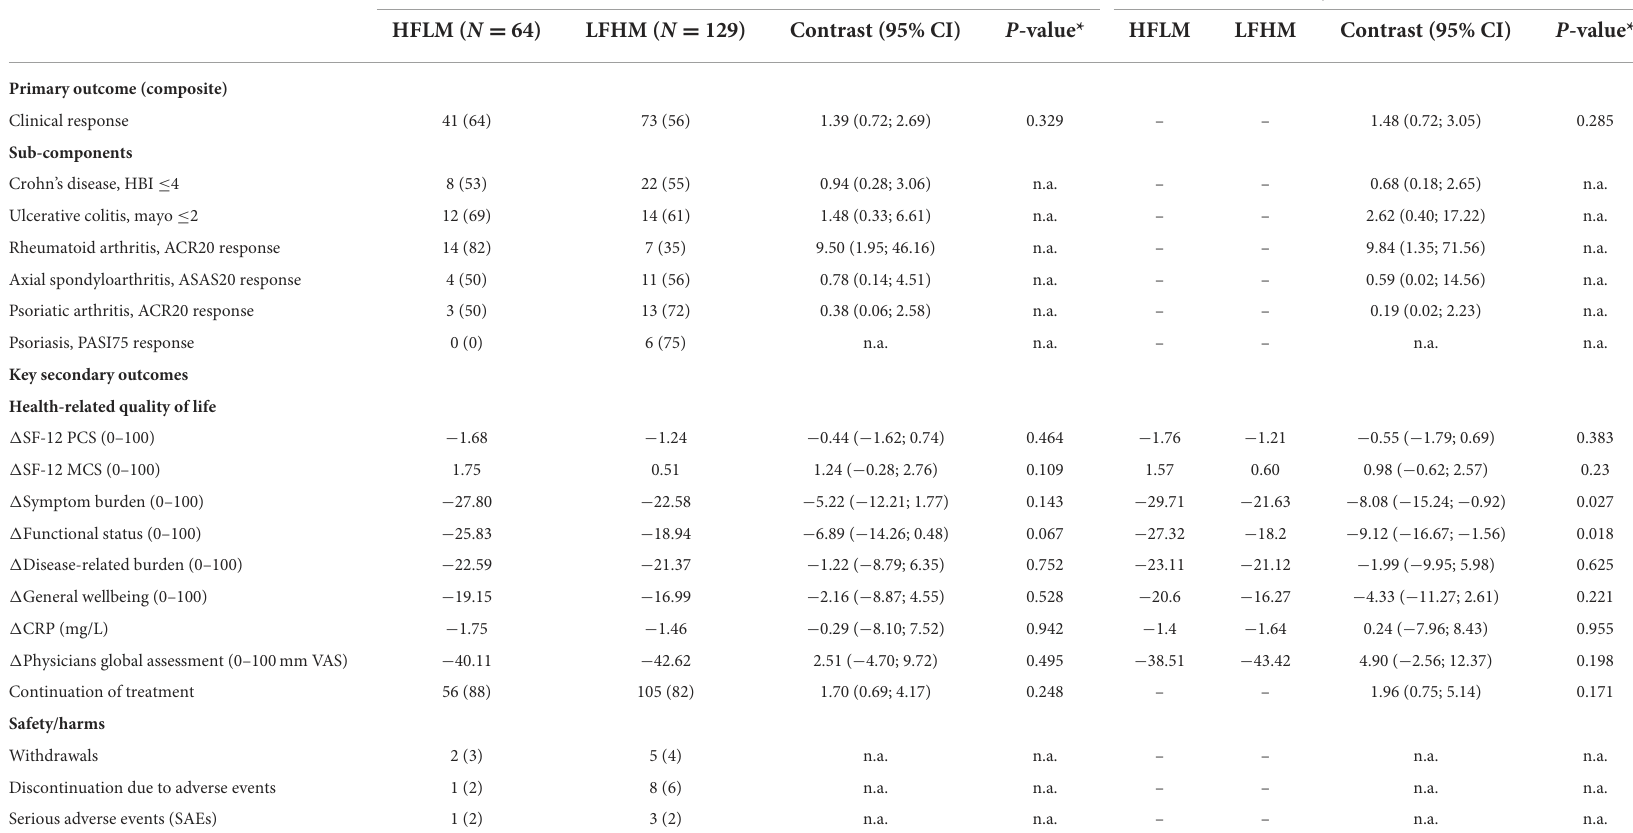
TABLE 2 Primary and key secondary